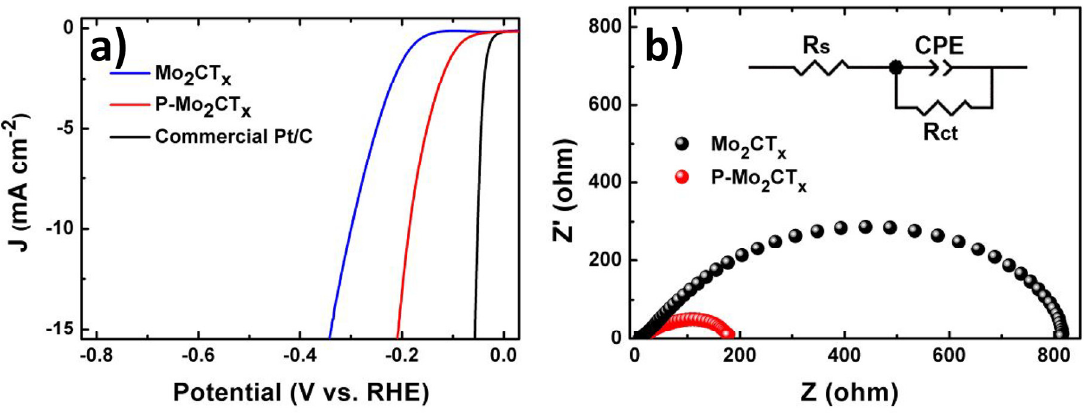
Figure 8. ( a ) Mo2CTx, P–Mo2CTx-HER polarization curves, and commercial Pt/C (20 wt % Pt. ( b ) EIS of Mo2CTx and P–Mo2CTx. Reprinted with permission from [144]. of Mo2CTx and P–Mo2CTx. Reprinted with permission from